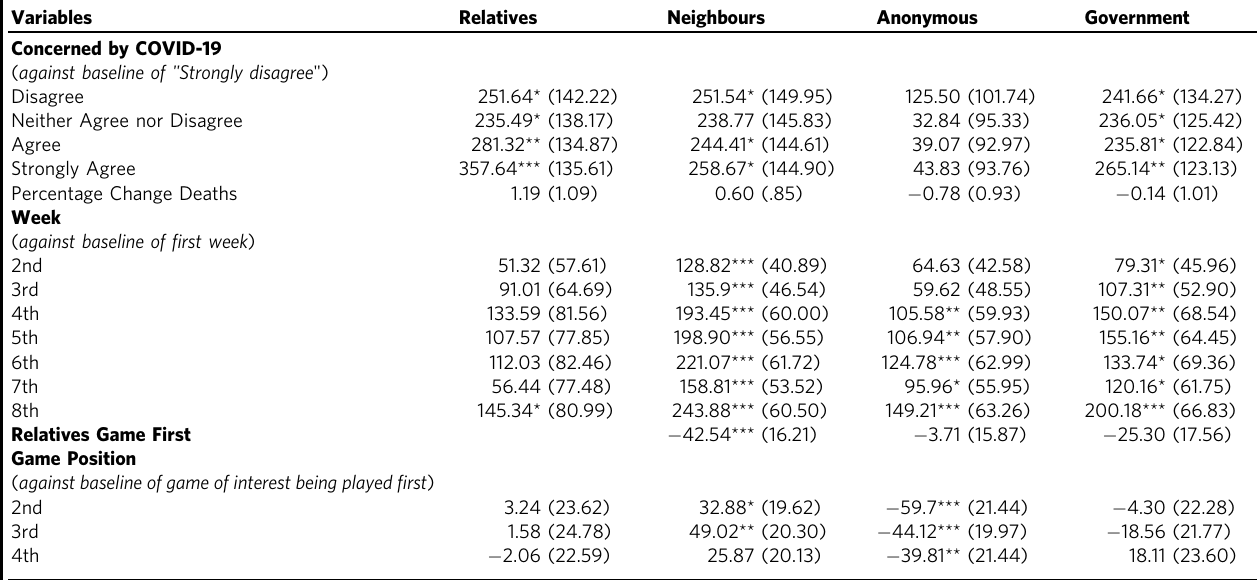
Table 2 Tobit regressions on amount donated, by